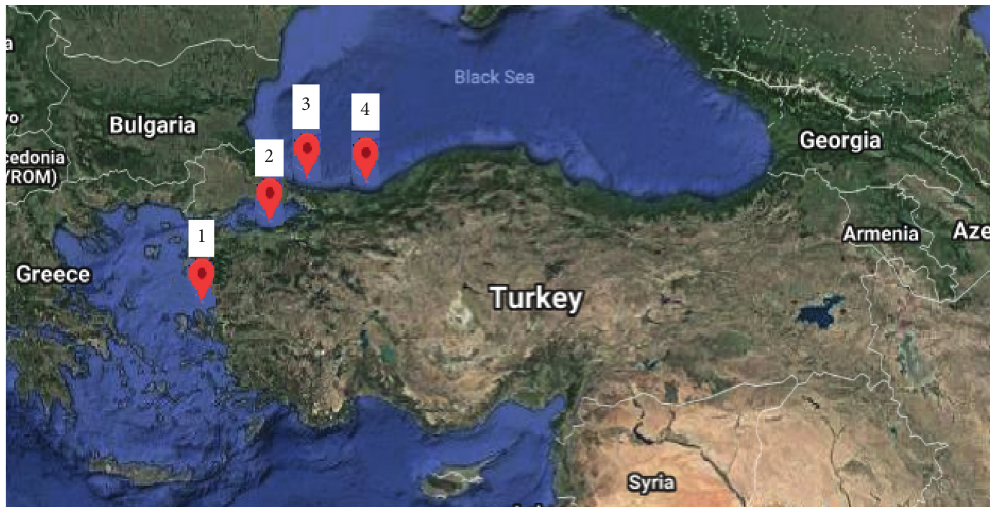
Figure 1: General view of sampling area.